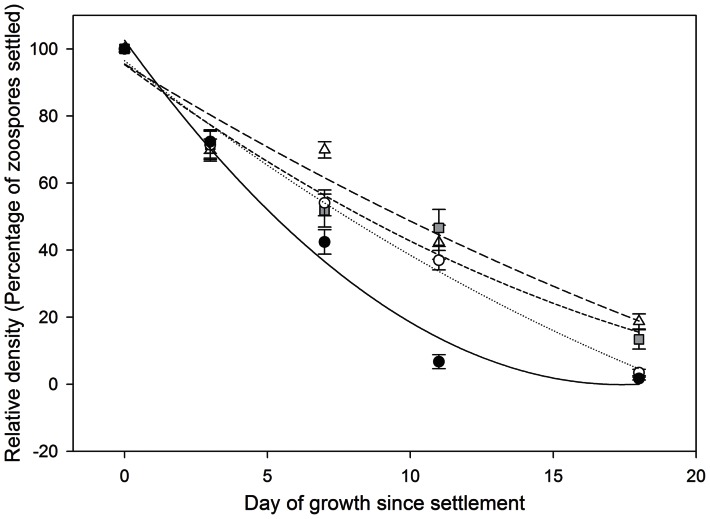
Mean survival (±SE) over 18 days from samples collected on the 24 January 2011.Gametophytes were grown in four different temperatures; 16°C (white triangle, long dash line), 18°C (grey square, small dash line), 20°C (white circle, dotted line), 22°C (black circle, solid line). Lines shown are quadratic regressions.